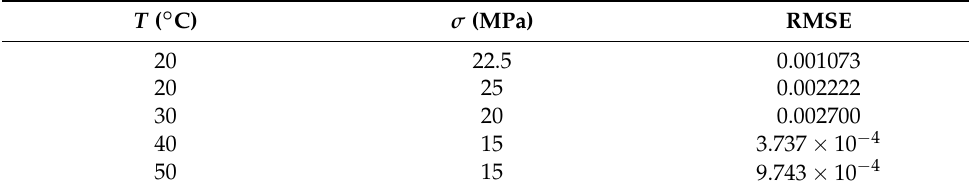
Figure 12. Comparisons of the predicted creep strain results (in solid lines) with the actual creep data (in dashed lines). ( a ) 20 ◦ C, 30 ◦ C, and ( b ) 40 ◦ C, 50 ◦ C. Table 3. Model performance in terms of